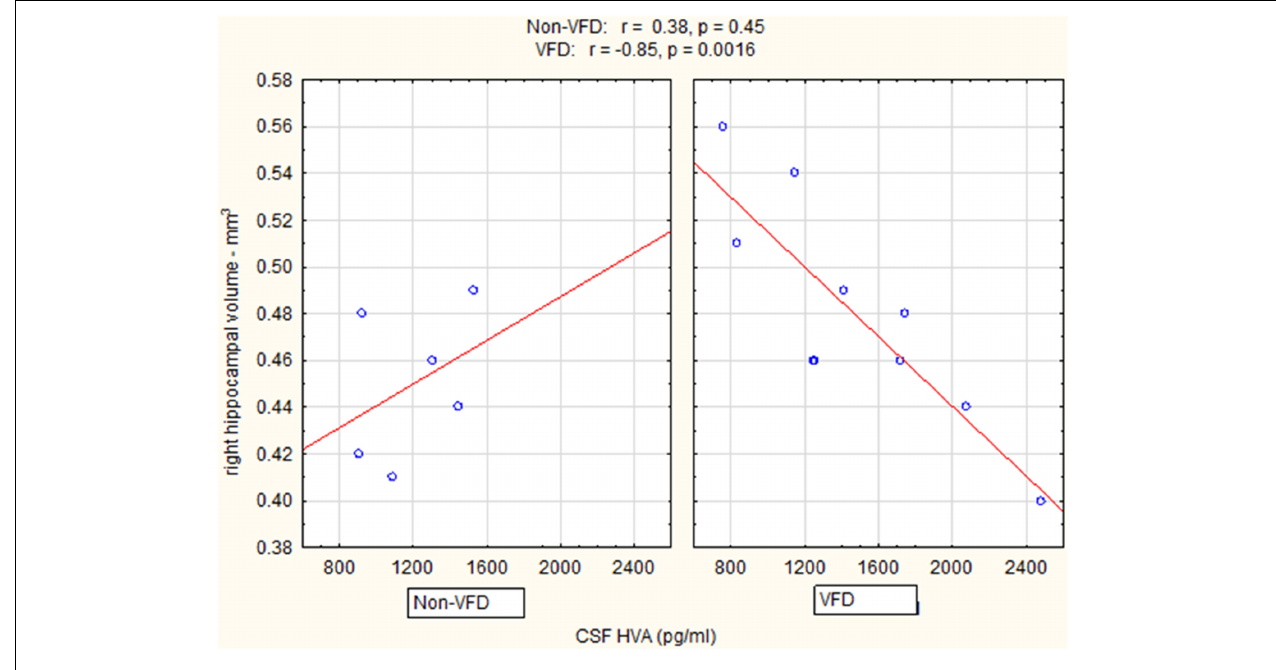
FIGURE 3 | Relationship between right hippocampal volume and CSF HVA as a function of early life stress. For CSF HVA, right hippocampus correlated inversely in VFD-reared subjects and but not